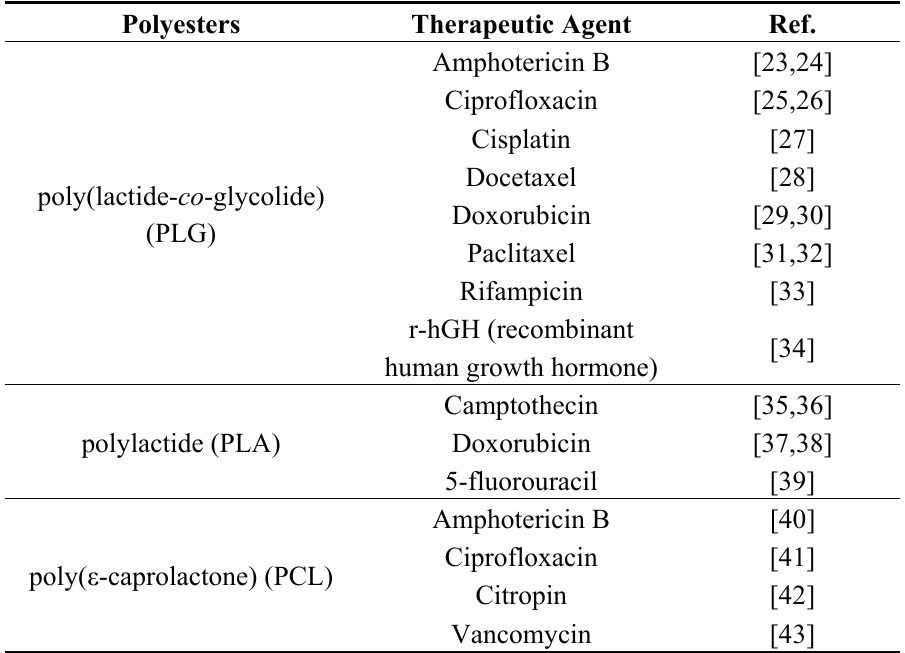
Table 1. Examples of DDS obtained from